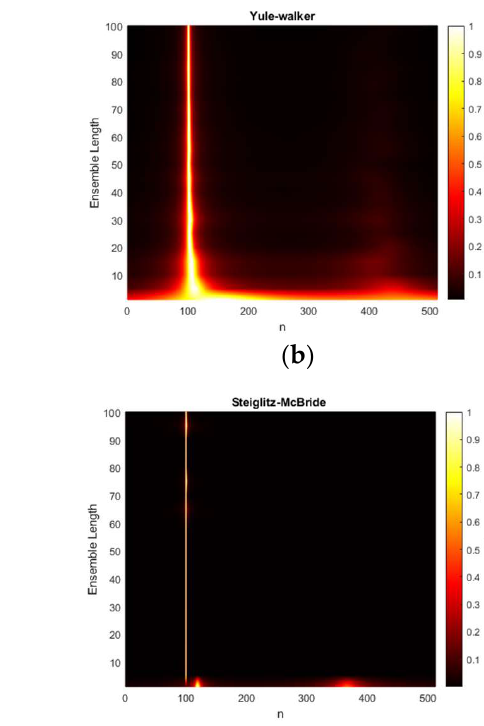
Figure 9. Estimated ℎ (cid:3560) [𝑛] distribution (normalized) with given ensemble average length & 0 dB SNR from: ( a ) non-parametric HD top-view (interpolated); ( b ) Yule-walker HD top-view (interpolated); ( c ) Prony HD top-view (interpolated); ( d ) Steiglitz-McBride HD top-view (interpolated).